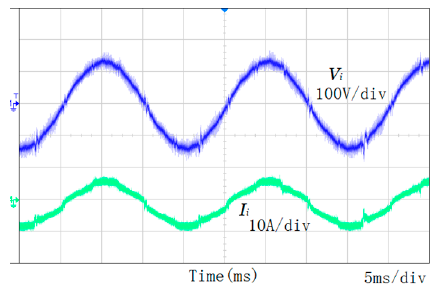
Figure 16. Input one of three phase volt and current.